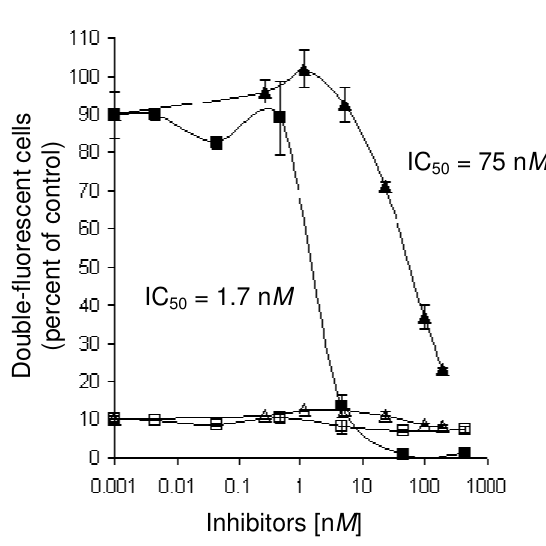
FIGURE 6 . Effect of the fusion inhibitor peptide T-20 (squares) and anti-CD4 monoclonal antibody (triangles) on cell fusion (black symbols) and cellular aggregation (white symbols), as analyzed by the FRET-based flow cytometry method. Fused cells are sensitive to both inhibitors to different extents, while aggregated cells are not appreciably affected. (Reprinted from Huerta et al.[87]. Copyright 2006, with permission from